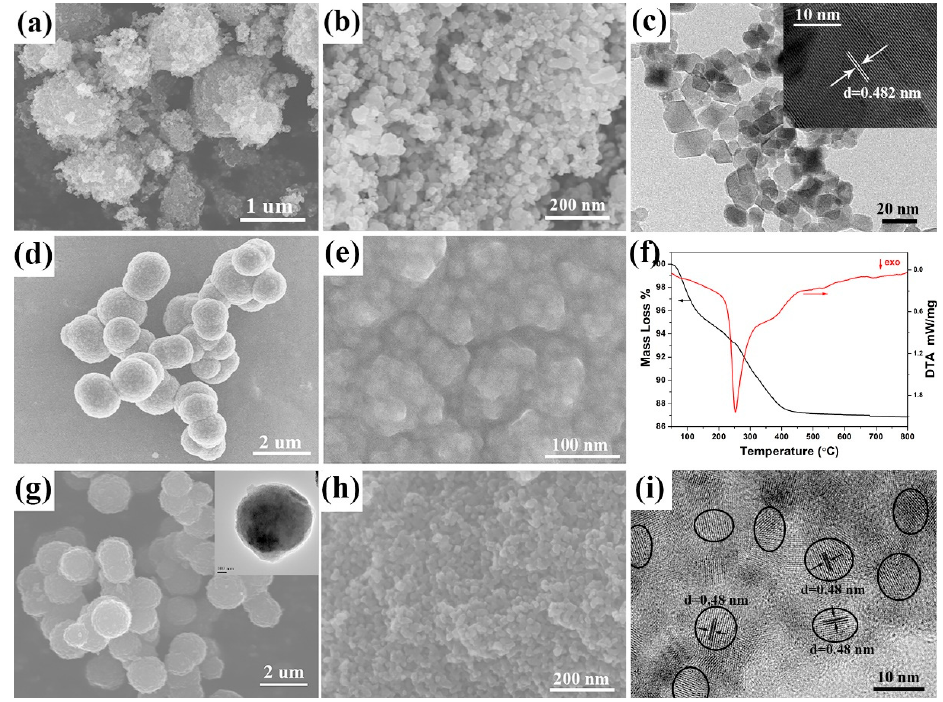
Figure 3. The SEM and TEM images of the ( a – c ) n-ZGO, ( d , e ) ZGO@C and ( g – i ) P-ZGO samples with different magnifications, and ( f ) shows the TG/DTA curves of the ZGO@C sample in flowing air.